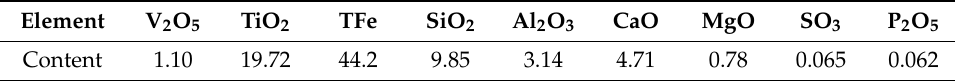
Table 1. Analyses of main chemical composition of the concentrate wt %.